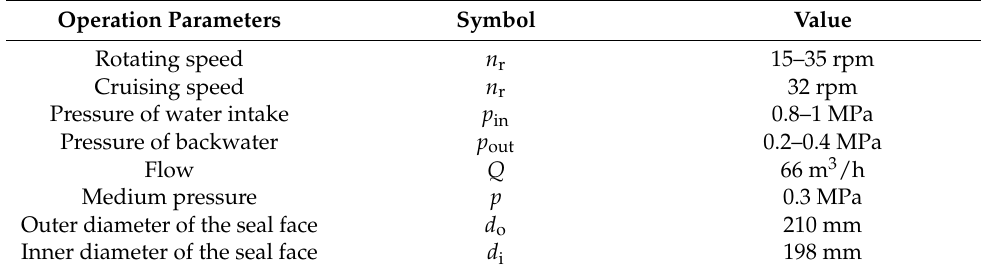
Table 3. Operating parameters of mechanical seal.